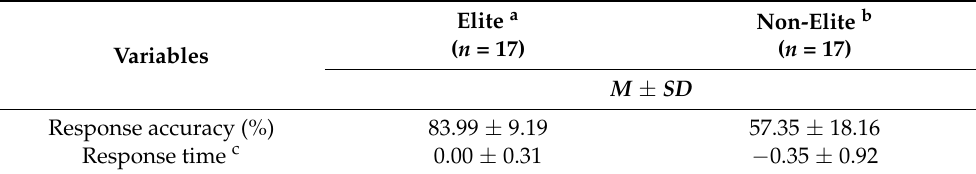
Table 1. Descriptive statistics for the diagnostic results separated by performance level serving as predictor variables in the logistic regression analysis.